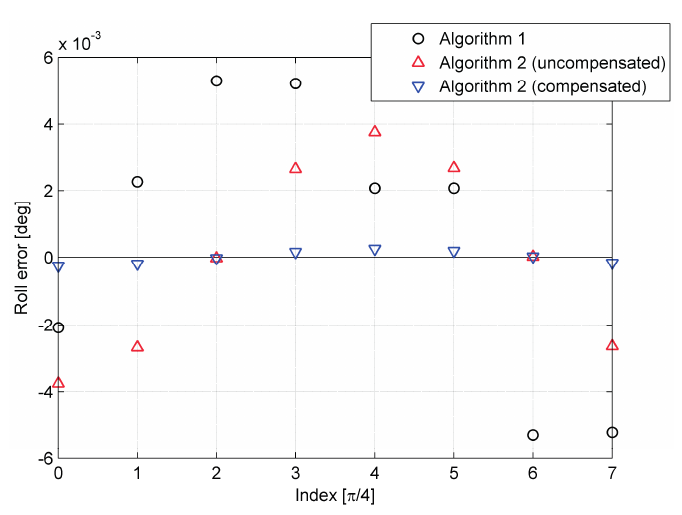
Figure 7. Pitch error of the eight simulations.